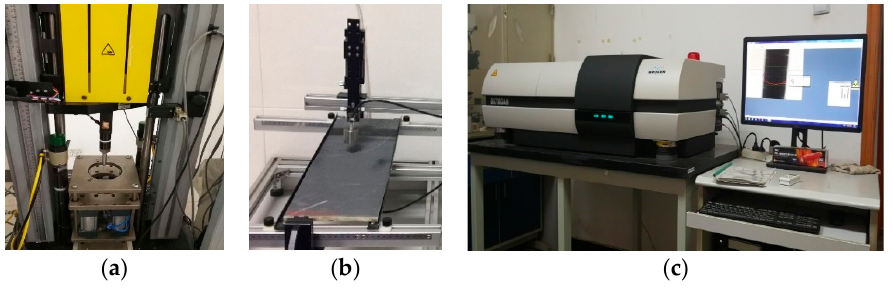
Figure 2. ( a ) INSTRON Dynatup 9250HV, ( b ) C-scan instrument, ( c ) Micro-CT scan system.